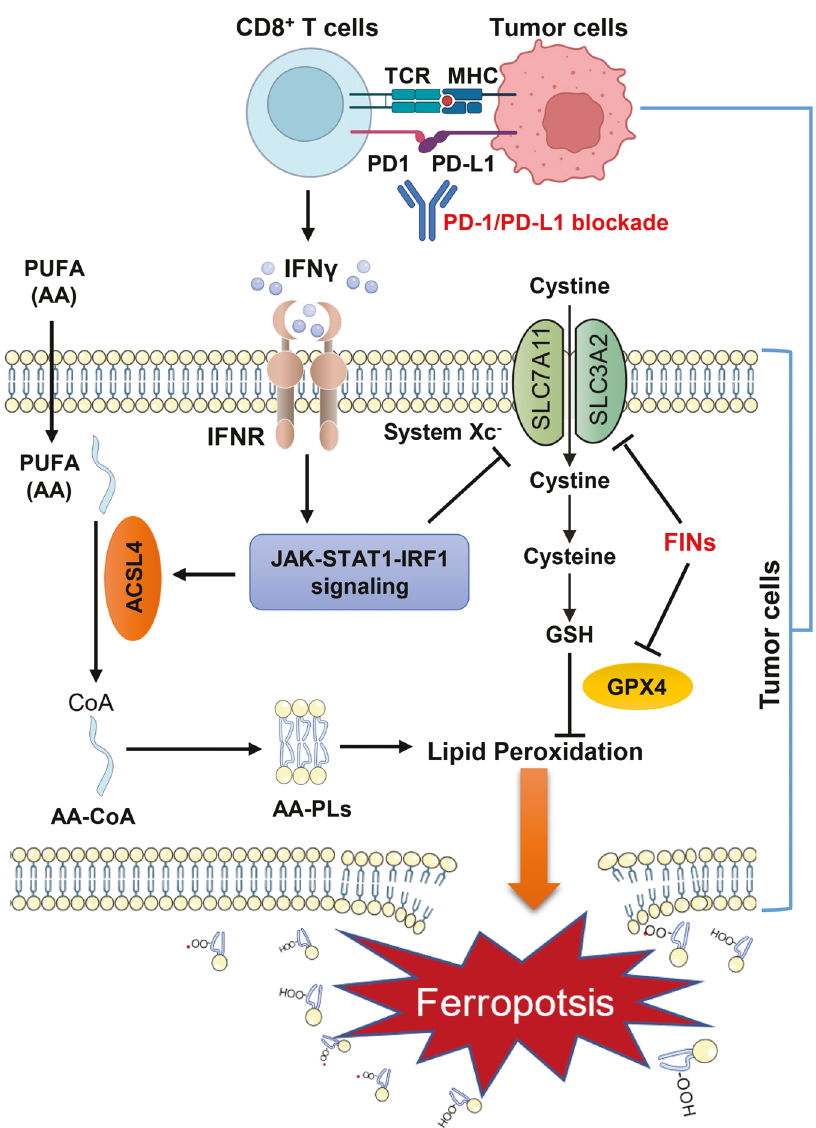
Fig. 1 PUFAs and CD8 + T-cell-derived IFN γ act in concert to induce tumor ferroptosis and mediate anti-tumor immunity. PUFA-PLs in the cellular membrane are susceptible to peroxidation, and excessive lipid peroxidation leads to membrane rupture and ferroptosis. Lipid peroxidation is kept in check by ferroptosis defense mechanisms mediated by GSH-GPX4 signaling, wherein GPX4 utilizes GSH to neutralize lipid peroxides, and cystine uptake mediated by system Xc – (which consists of SLC7A11 and SLC3A2) provides the key precursor cysteine for GSH synthesis. Blocking system Xc – or inactivating GPX4 by FINs curbs ferroptosis defense and induces ferroptosis in tumor cells. IFN γ secreted by CD8 + T cells binds to IFNR, activates the JAK-STAT1-IRF1 signaling axis, and induces ACSL4 expression in tumor cells. The increase in ACSL4 expression, in combination with AA supplementation, promotes AA containing-PL synthesis. In addition, IFN γ reduces SLC7A11 expression and weakens ferroptosis defense in tumors cells. These two effects caused by combined treatment with IFN γ and PUFAs (namely increased AA-PL synthesis and weakened ferroptosis defense) induce potent ferroptosis in tumor cells. Consequently, PUFA treatment enhances anti-tumor immunity and its combination with immune checkpoint blockade therapies (such as PD-1/PD-L1 blockade) exerts potent tumor suppressive effects. Figure adapted from images created in Biorender. AA arachidonic acid, ACSL4 acyl-coenzyme A synthetase long- chain family member 4, CoA coenzyme A, FIN ferroptosis inducer, GPX4 glutathione peroxidase 4, GSH reduced glutathione, IFN γ interferon γ